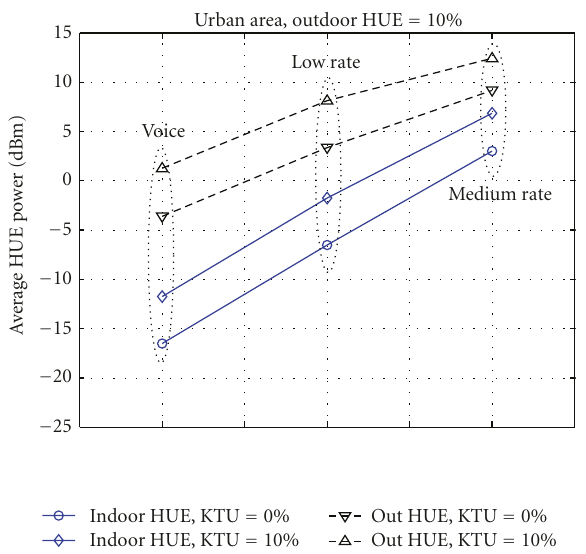
Figure 7: Average transmit power of HUEs in urban